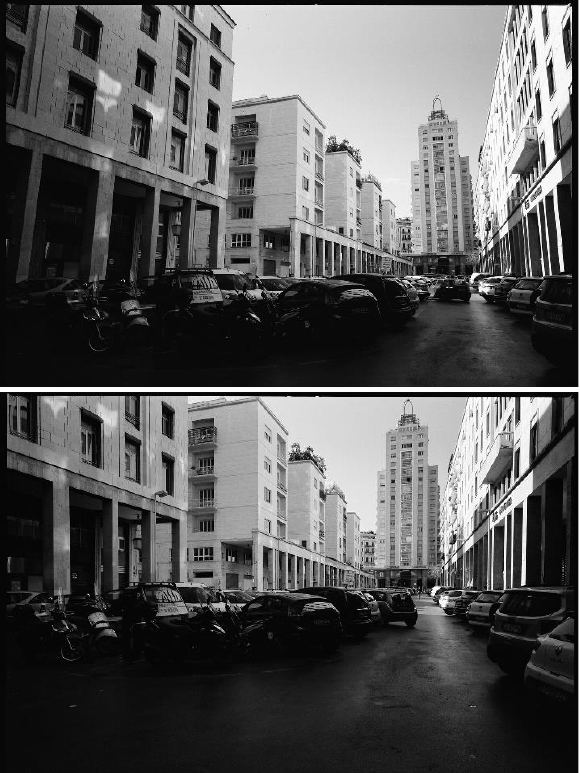
Figure 10: Photos taken with a view camera in neutral position (above) and with the rear standard tilt correction